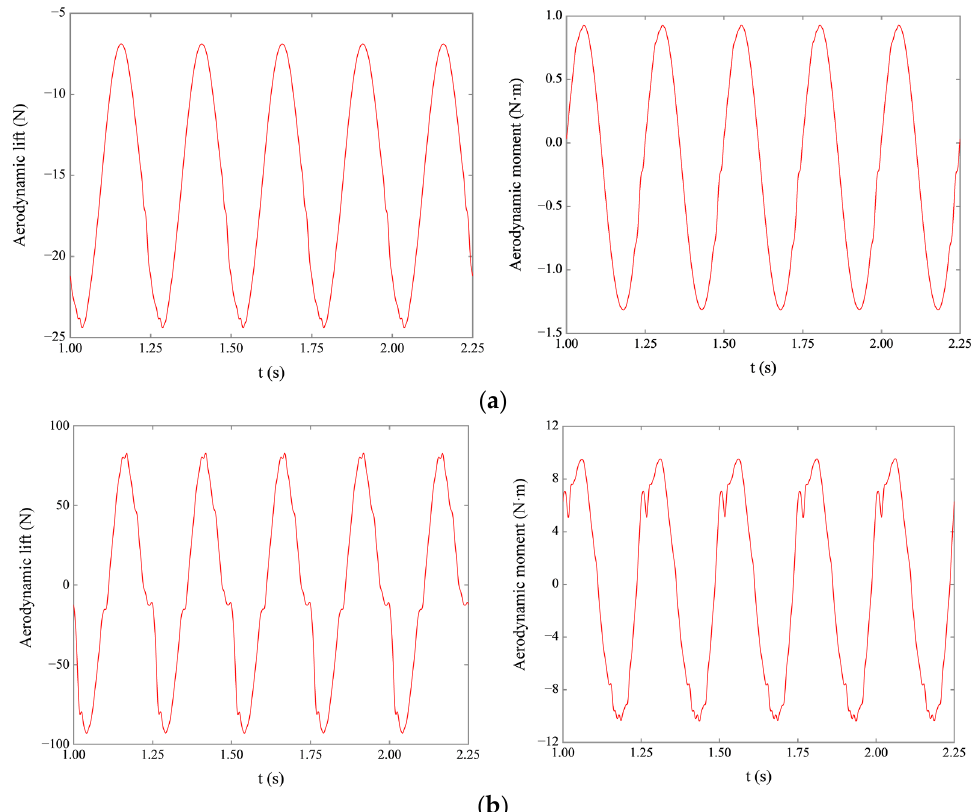
Figure 9. Time history curve of aerodynamic forces. ( a ) Small amplitude motion ( α 0 = 2°, h 0 = 0.02 B ). ( b ) Large amplitude motion ( α 0 = 20°, h 0 = 0.2 B ).